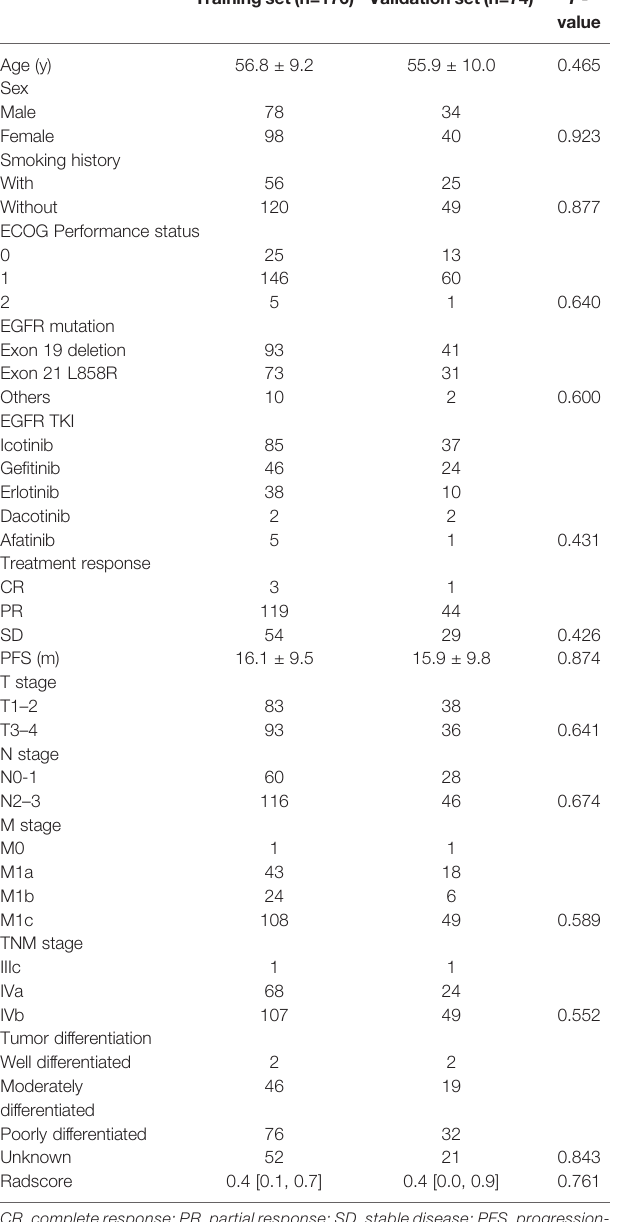
TABLE 1 | Baseline characteristics at biopsy after progression on fi rst-line epidermal growth factor receptor tyrosine kinase inhibitors. Trainingset (n=176) Validation set